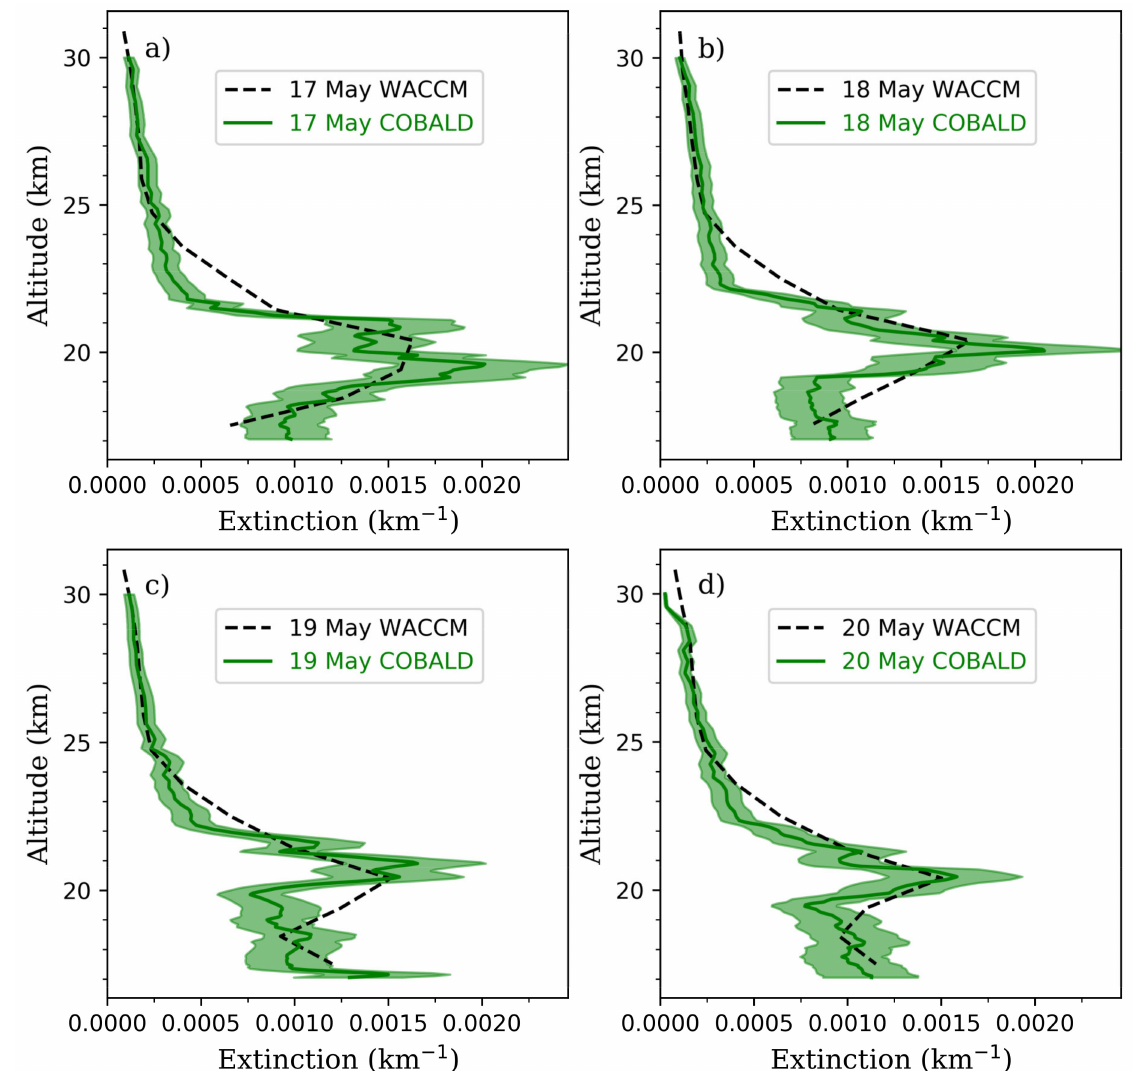
Figure 5. Extinction Profiles at 532 nm observed by the COBALD instrument during the 2014 KlAsh campaign (full lines)) and compared with WACCM-CARMA outputs from the volcano-on simulation (dashed line) at the closest grid point on ( a ) 17 May 2014, ( b ) 18 May 2014, ( c ) 19 May 2014, and ( d ) 20 May 2014 COBALD uncertainties (shaded areas) are derived accounting for a lidar ratio of 45sr+/ –10 as used in Vernier et al. (2016)